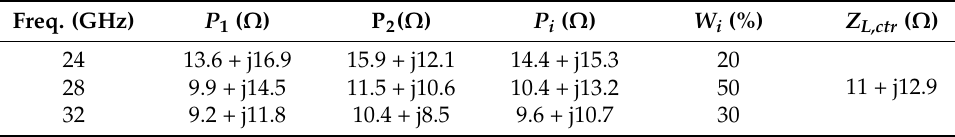
Table 2. Contour peaks and weighted averages at discrete frequencies.